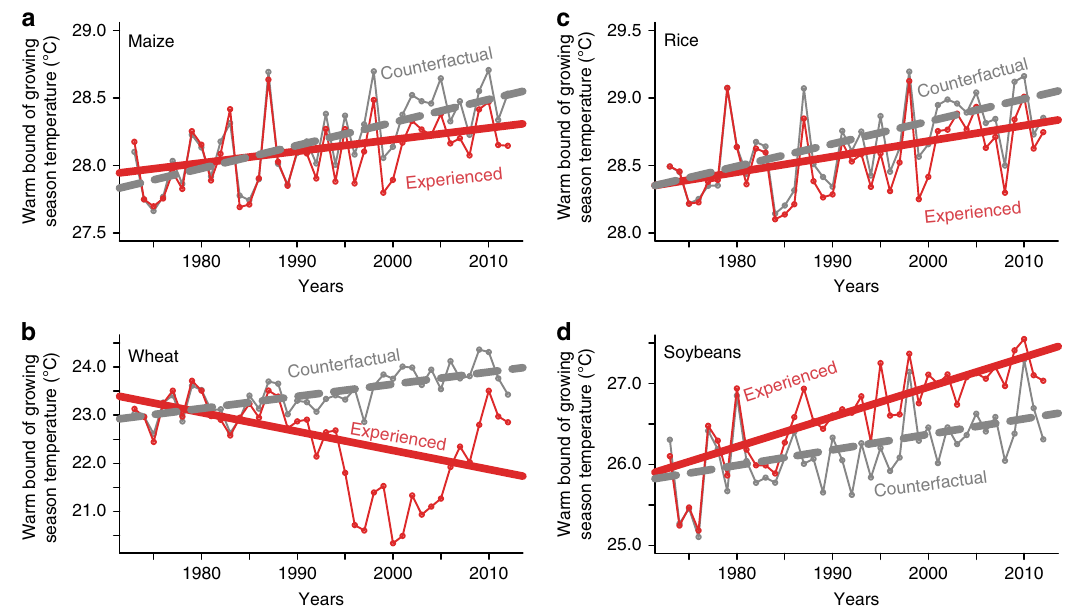
Fig. 4 95th percentile trends in growing season temperature over time. Plots show the quantile regression trends in the warm bound (95th percentile) of growing season temperatures between 1973 – 2012 for rainfed harvested areas. Results are consistent with climate adaptation for maize ( a ), wheat ( b ), and rice ( c ), and niche expansion for soybeans ( d ). Red lines indicate observed temperature trends that are in fl uenced by changes in crop area and climate, whereas gray dashed lines represent a counterfactual scenario where rainfed harvested areas remain static at the 1973 – 1977